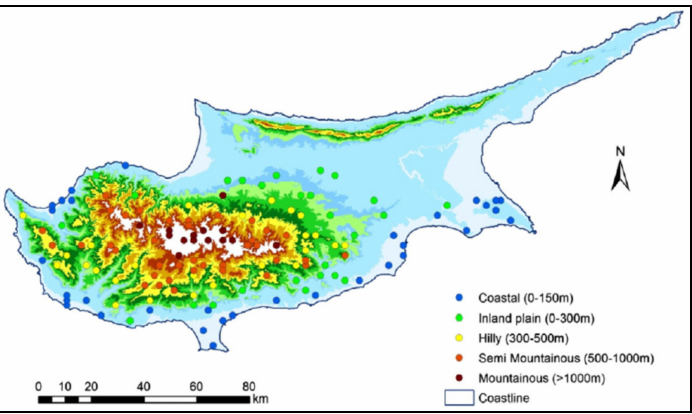
Figure 1. Geomorphology map of Cyprus highlighting the distribution of the dense gauge station network grouped according to